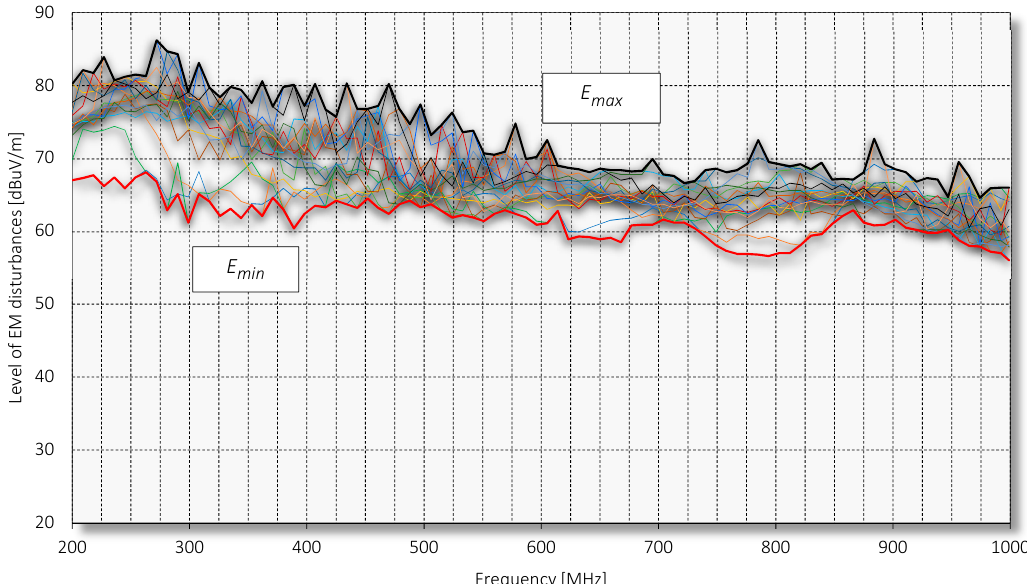
Figure 9. Levels of electromagnetic disturbances (valuable emissions, 15 measured devices of the same type) measured for desktops B in the range of frequencies from 200 MHz to 1 GHz, BW = 50 MHz, measurement distance: 1 m.